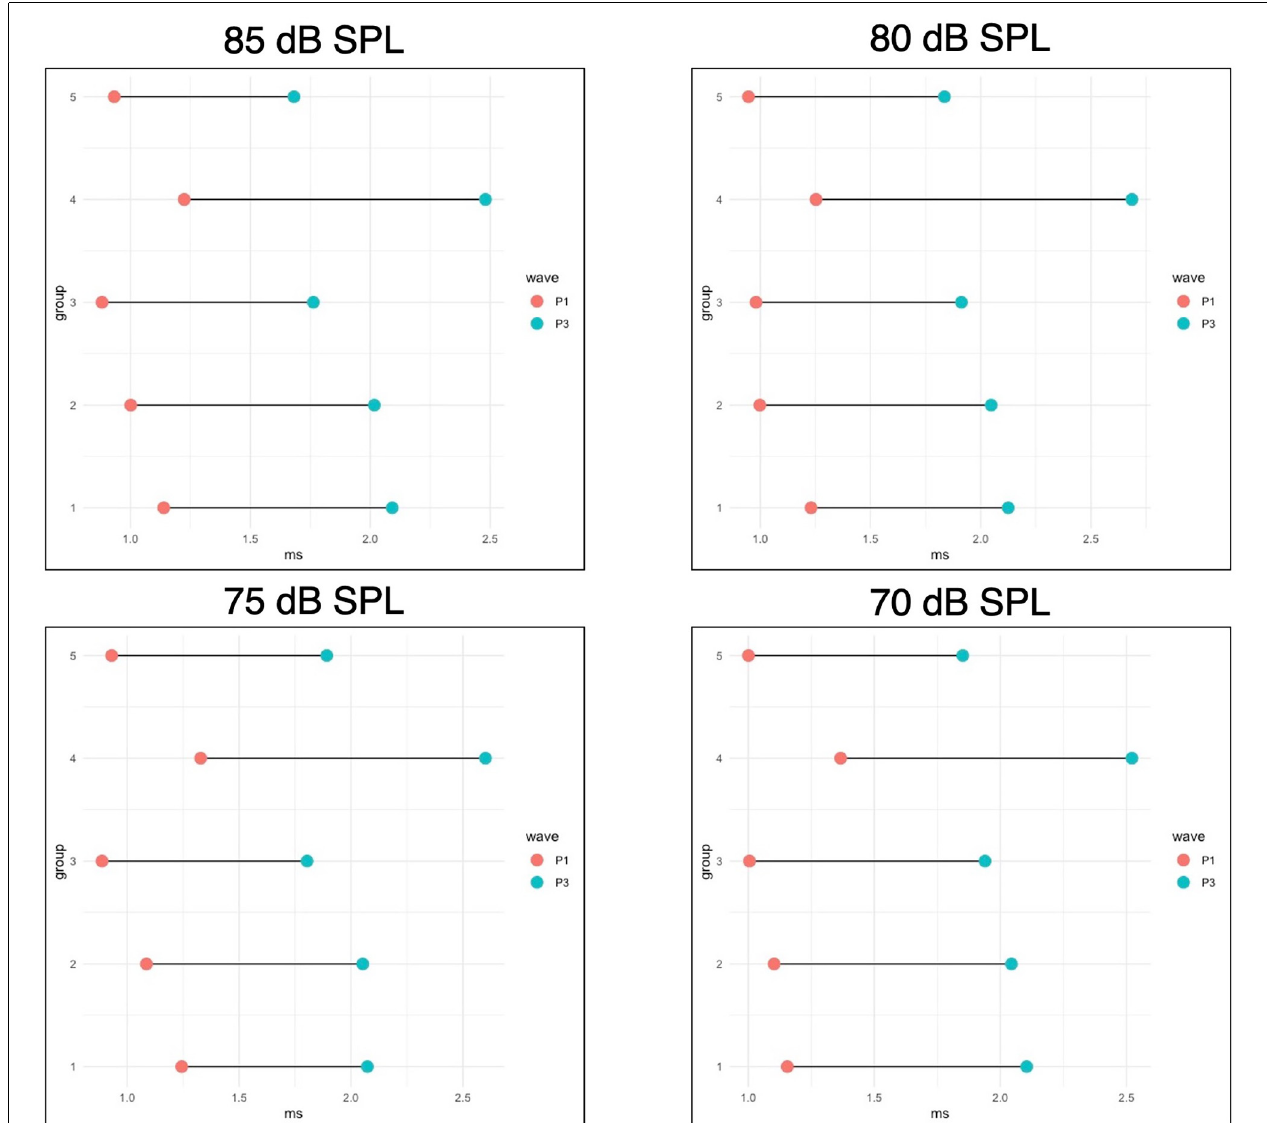
FIGURE 4 | Wean ABR latencies. This figure shows the mean P1 and P3 latencies for offspring measured at wean for four intensities (90 dB SPL is not pictured, but no significant differences were seen at this level). P1-P3 interpeak latencies are represented by the bars connecting the points for each group. Group 4 had a